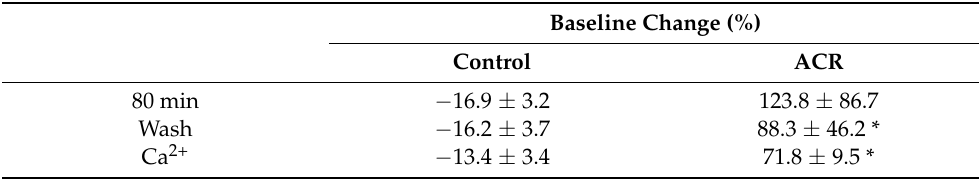
Table 4. Effect of ethylene glycol tetra-acetic acid with or without acrylamide treatment on the isolated mouse phrenic